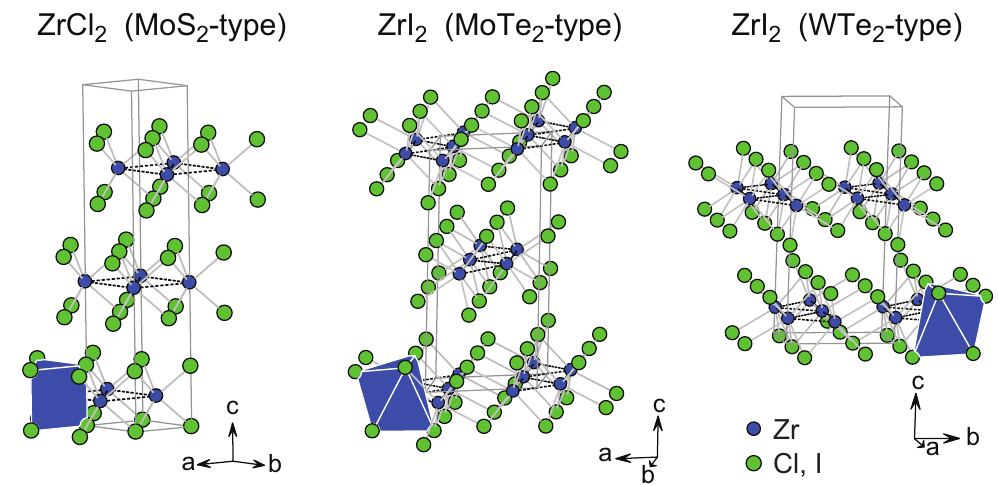
Figure 2. Crystal structures of layered Zr X 2 compounds. A single Zr coordination polyhedron is shown for each